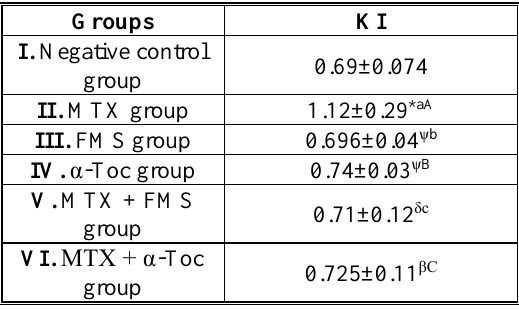
Table 3.Effects of fimasartan on the kidney index